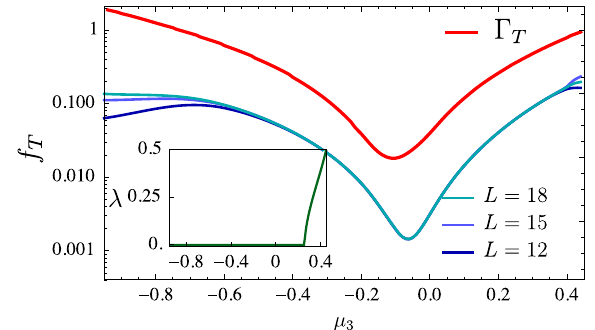
effect of the applied perturbation. The data illustrate that f system size independent and therefore is well defined for μ ∈ ½ − 0 . 6 ; 0 . 4 (cid:2) . The inset shows that the Floquet exponent λ 3 becomes nonzero only for μ 3 > 0 . 255 , suggesting that there is no direct relation between λ and leakage. Finally, for μ 3 ≥ 0 . 45 , the periodic trajectory